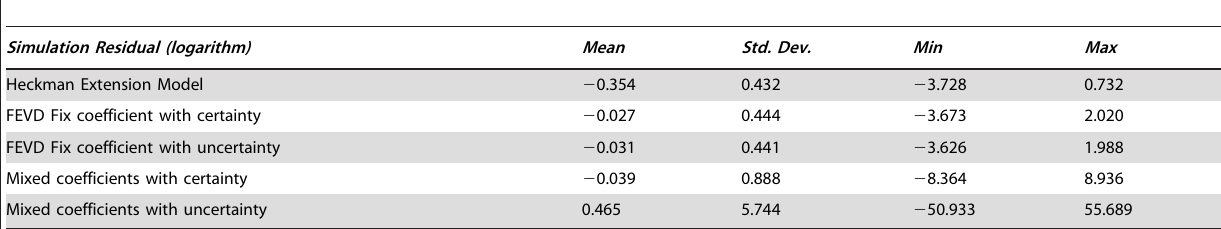
Table 7. Simulation Models